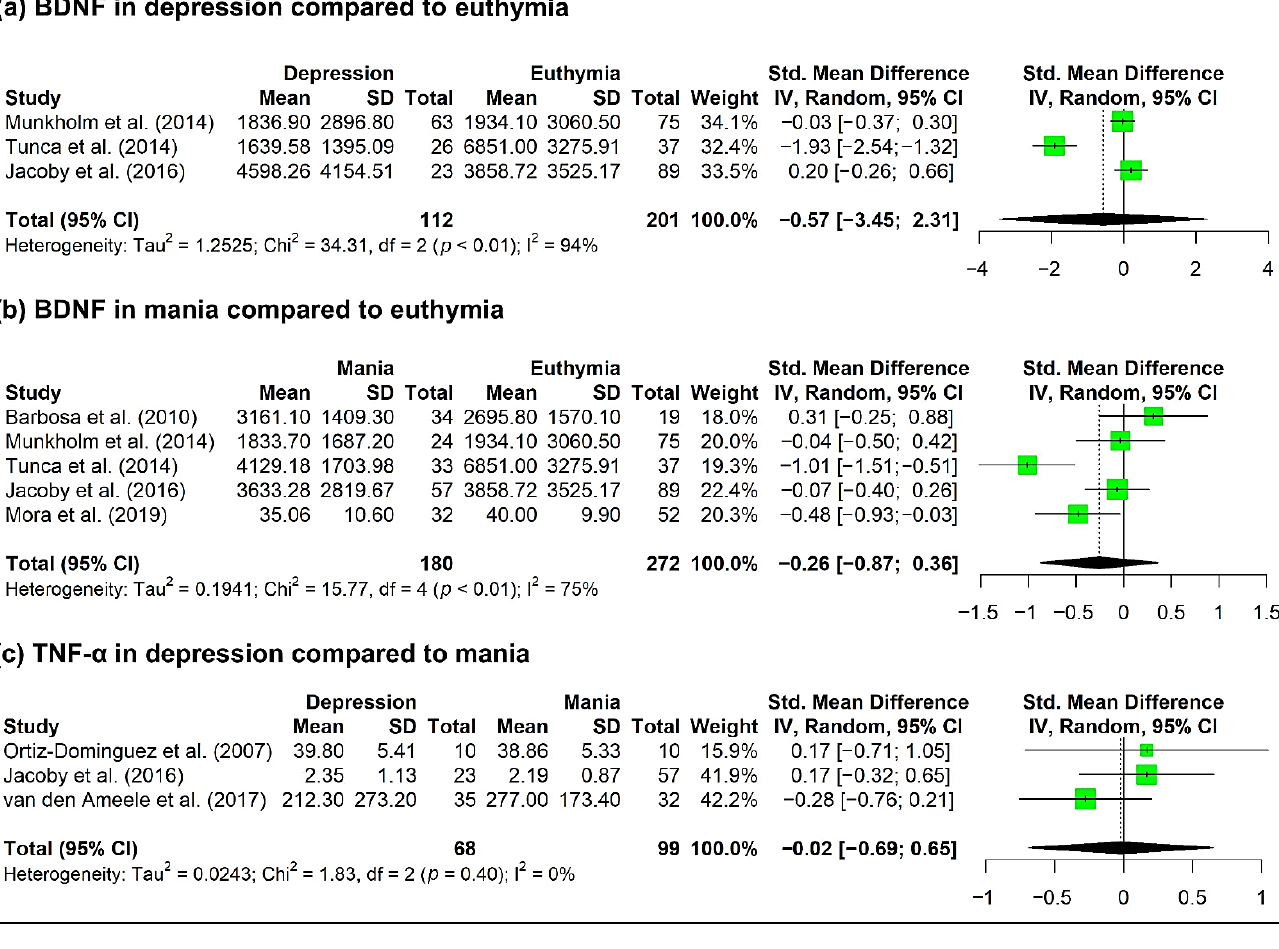
Figure 3. Forest plot of the meta-analysis of BDNF in ( a ) depression compared to euthymia from the data of three selected studies (18, 33a, 42 in Table 1), ( b ) mania compared to euthymia ( b ) from the data of five selected studies (2, 18, 32, 33a, 42 in Table 1), and ( c ) TNF- α in depression compared to mania from the data of three selected studies (18, 34, 44a in Table